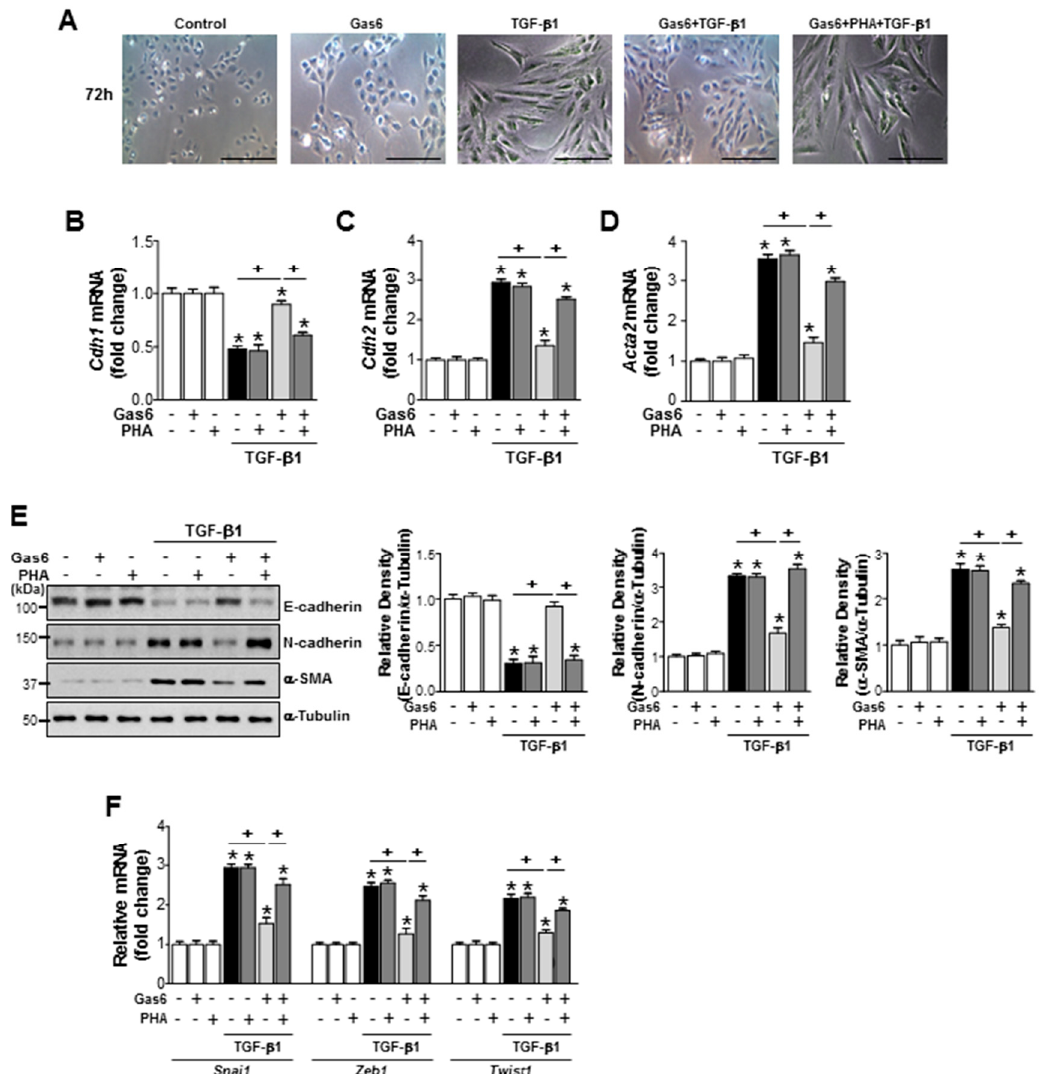
Figure 7. c-Met signaling mediates the Gas6-induced inhibition of EMT in LA-4 cells. LA-4 cells were treated with 400 ng / mL Gas6 for 20 h and then stimulated with 10 ng / mL TGF- β 1 for 72 h, with or without 250 nM PHA-665752. ( A ) Morphological changes in the cells were examined by phase-contrast microscopy (Scale bars = 50 µ m). ( B – D , F ) qPCR analysis of the mRNA levels of EMT markers and EMT-inducing transcription factors. ( E ) Immunoblots of total cell lysates were performed using anti-E-cadherin, anti-N-cadherin, or anti- α -SMA antibodies. Densitometry of the relative abundances of the indicated EMT markers. Alpha-tubulin was used as a control. Values represent the mean ± SEM of three independent experiments. * p < 0.05 compared with control; + p < 0.05, as indicated. Results are representative of three independent experiments.